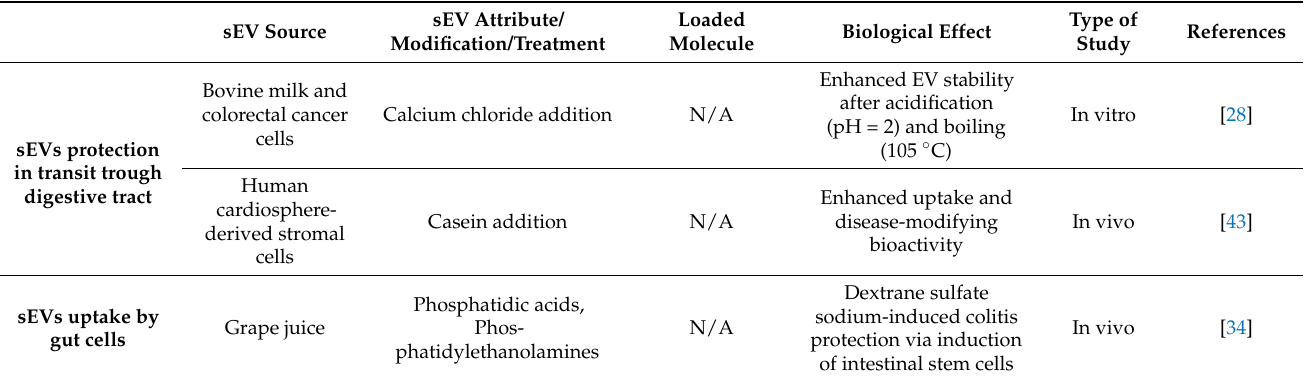
Table 3. Summary of sEVs reported attributes for oral